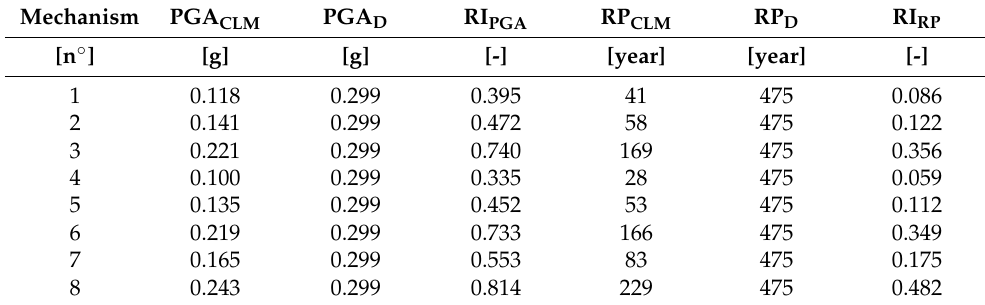
Table 4. Risk indices calculated for the different local collapse mechanisms (current configuration).